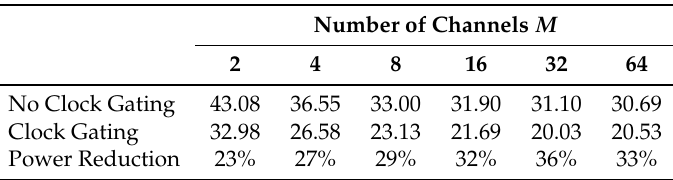
Table 5. The normalized power consumption ( µ W/channel) of the proposed circuit with and without clock gating for different numbers of channels M .